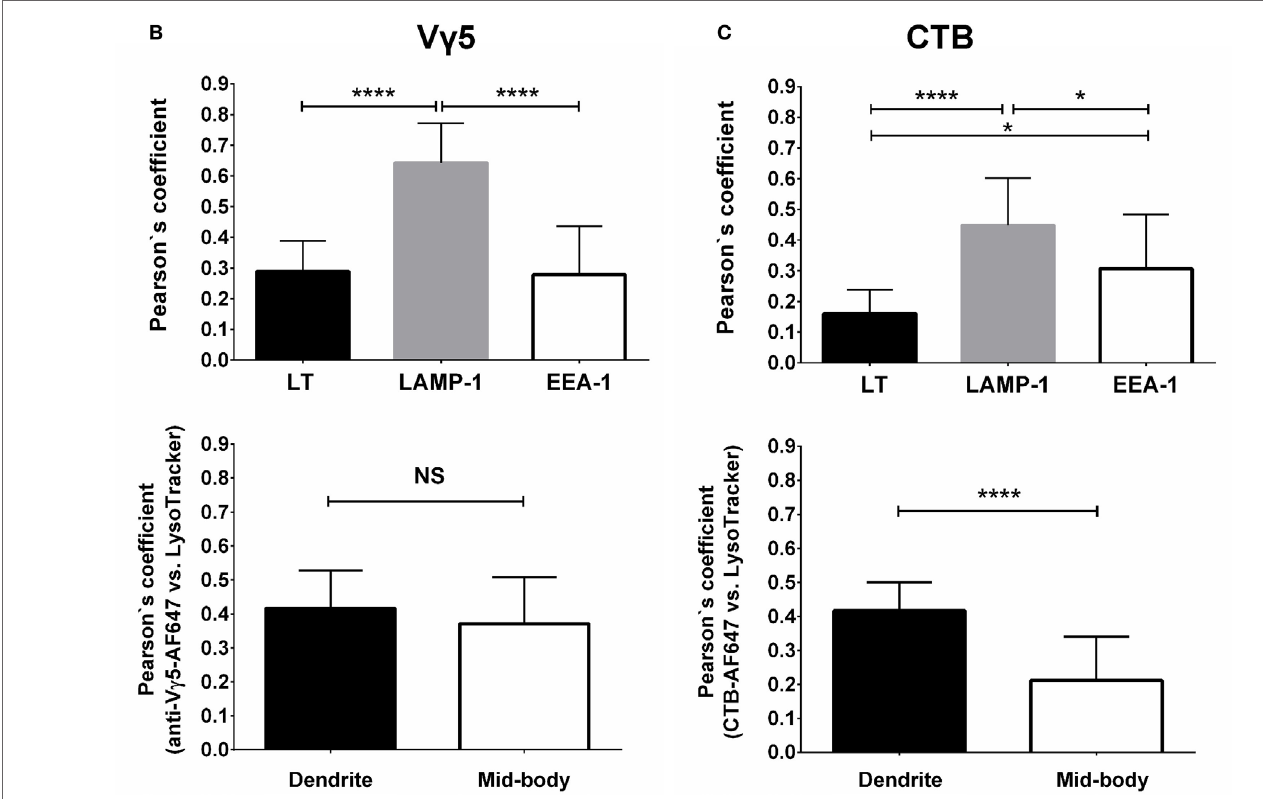
FigUre 2 | Characterization of dendritic epidermal T cell (DETC) granules containing internalized V γ 5 or CTB fluorescence. IL2p8-GFP mouse ear was injected with V γ 5-AF555 antibody or CTB-AF555 and, 6 days later, stained with LT or harvested for immunofluorescence. (a) Representative DETC examples. (B) Analysis of V γ 5 + granule co-localization with endosomal [early endosome antigen-1 (EEA-1)] and lysosomal [LAMP-1 and LysoTracker (LT)] markers in whole DETC bodies (upper panel) or in dendrites and mid-bodies (lower panel). (c) Similar as in (B) , but for CTB. N = 20–30 cells/mouse in five mice. The dendrite vs. mid-body co-localization analyses [ (B,c) lower panels] were performed on a subset of the cells in upper panels (i.e., where mid-bodies could be clearly delineated). Scale bar = 10